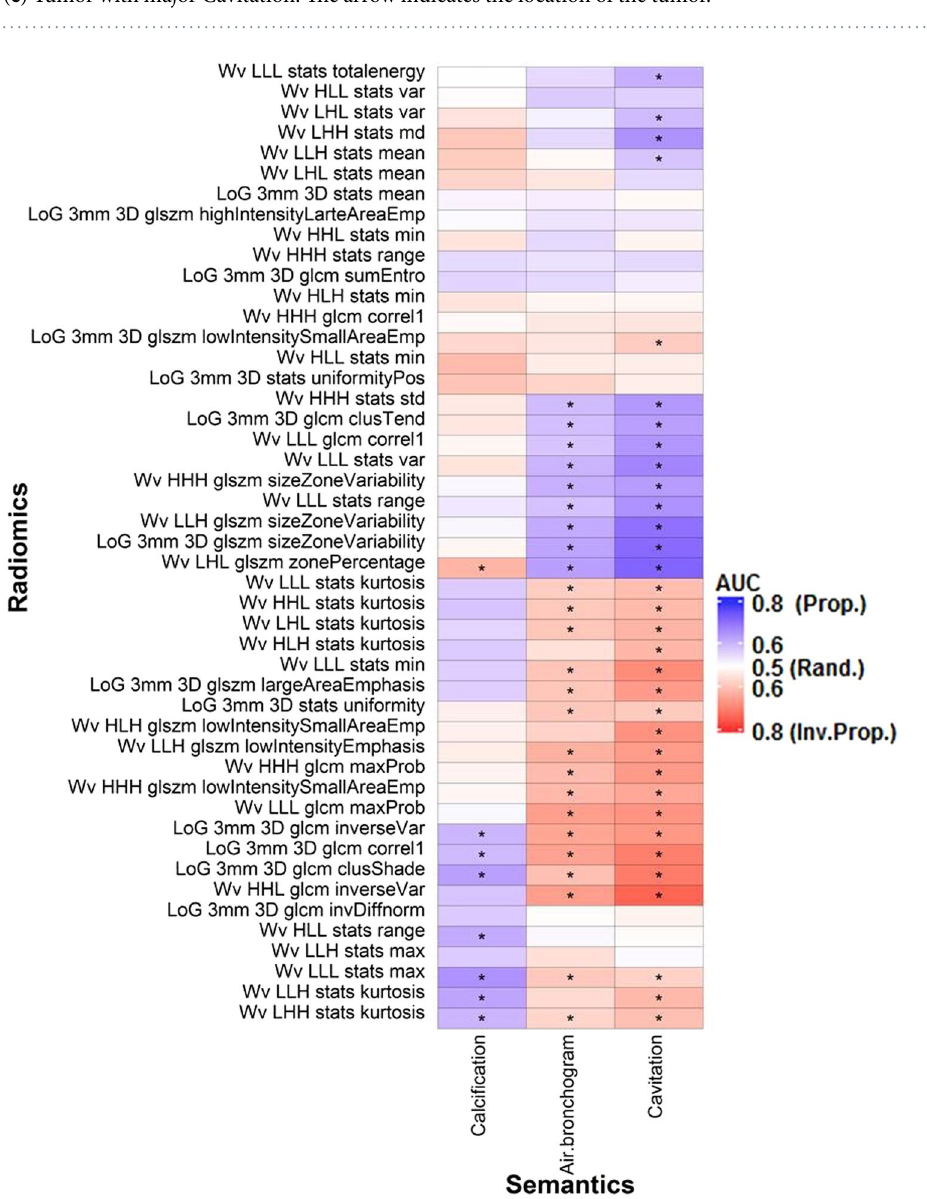
Figure 3. Associations between the binary semantic and unfiltered radiomic features assessed with the area under the ROC curve (AUC). * Indicates a significant association (q-value ≤ 0.05). “Rand.” = random association (AUC = 0.50). “Prop.” And “Inv. Prop.” indicate direct and inverse proportionality, respectively. Wv = Wavelet. LoG = Laplacian of